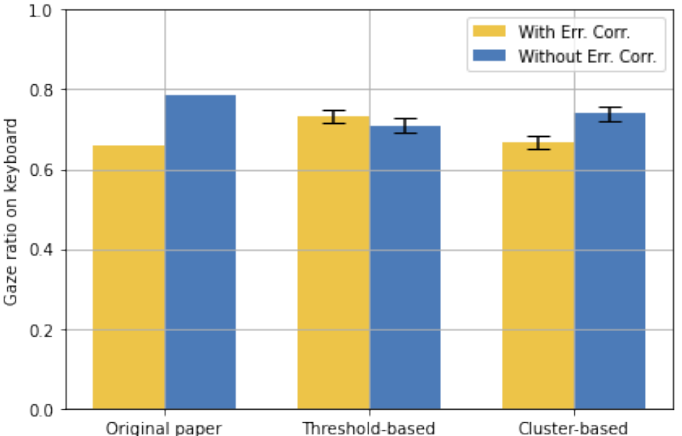
Figure 12. Gaze ratio spent on the keyboard area in Jiang at al.’s paper, and with our two detection algorithms.